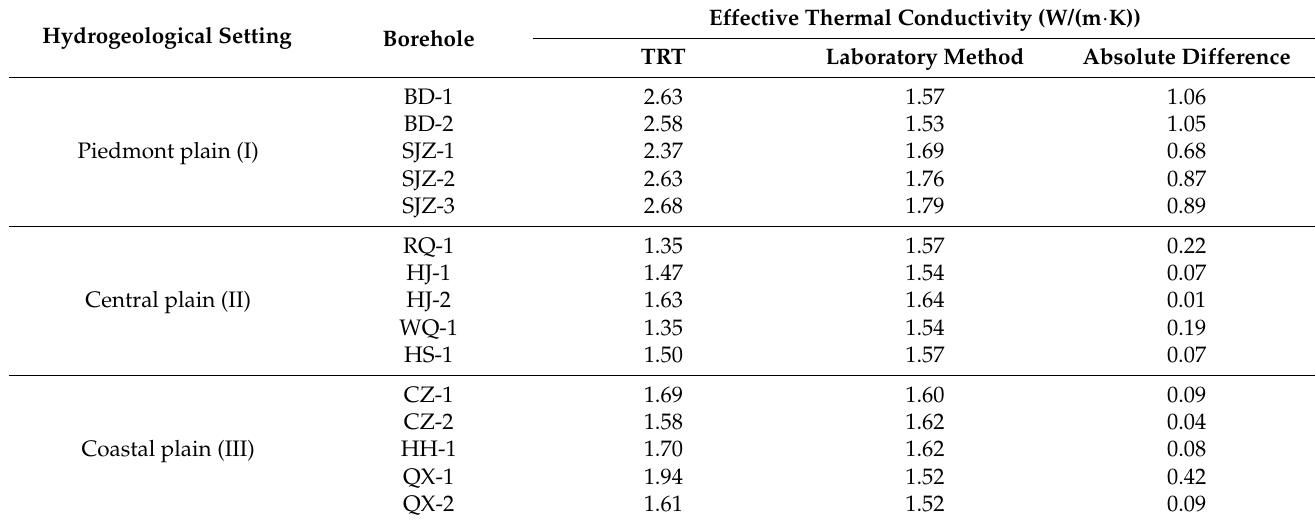
Table 7. The results of in situ thermal conductivity and laboratory methods of 15